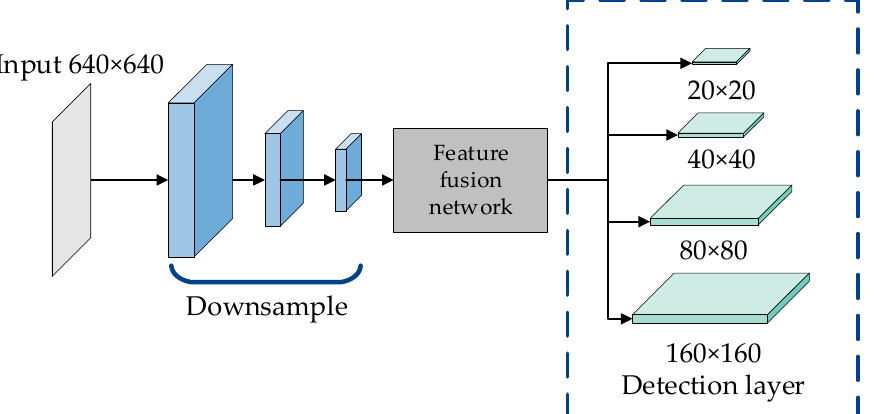
Figure 6. Improved four-scale detection layer.